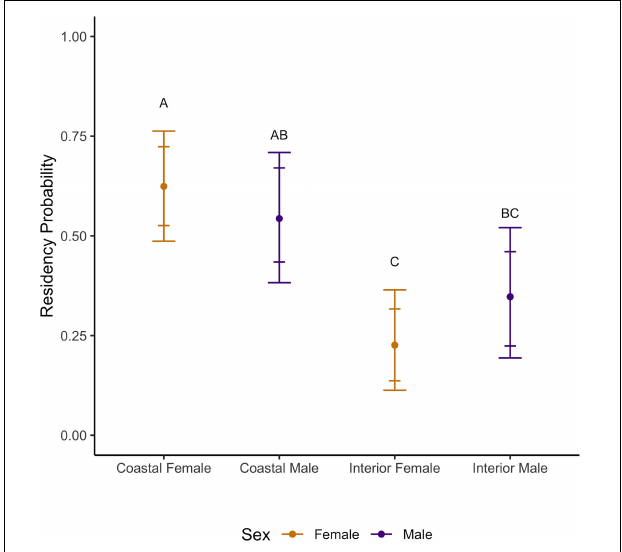
FIGURE 5 | Rufous hummingbird median residency probability (median ± 84 and 95% CI) by sex and region (1998–2017). Groups with shared lettering are not statistically